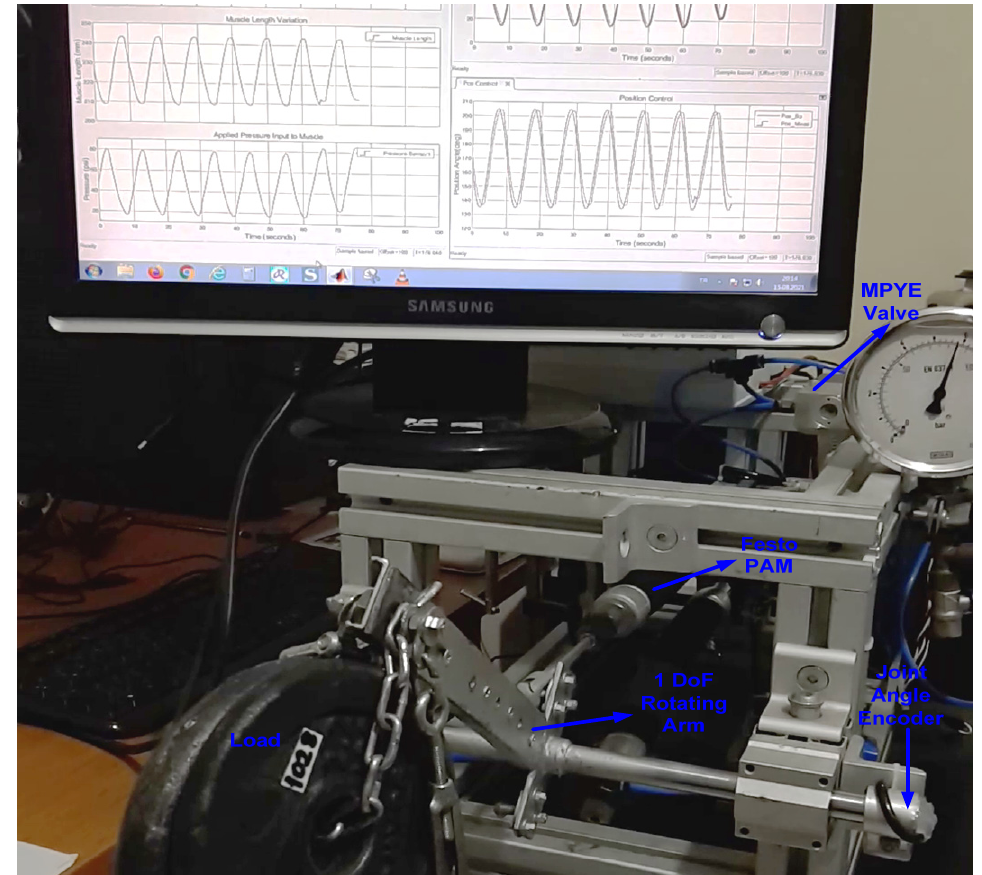
Figure 2. Rotating arm PAM testbed representing rehabilitation devices.